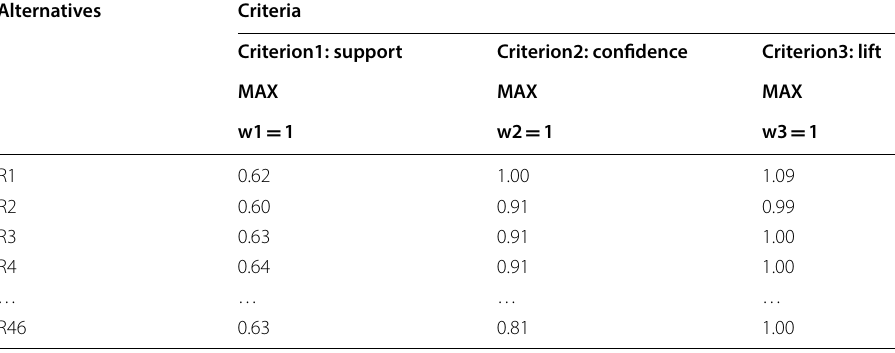
3 of the decision ×